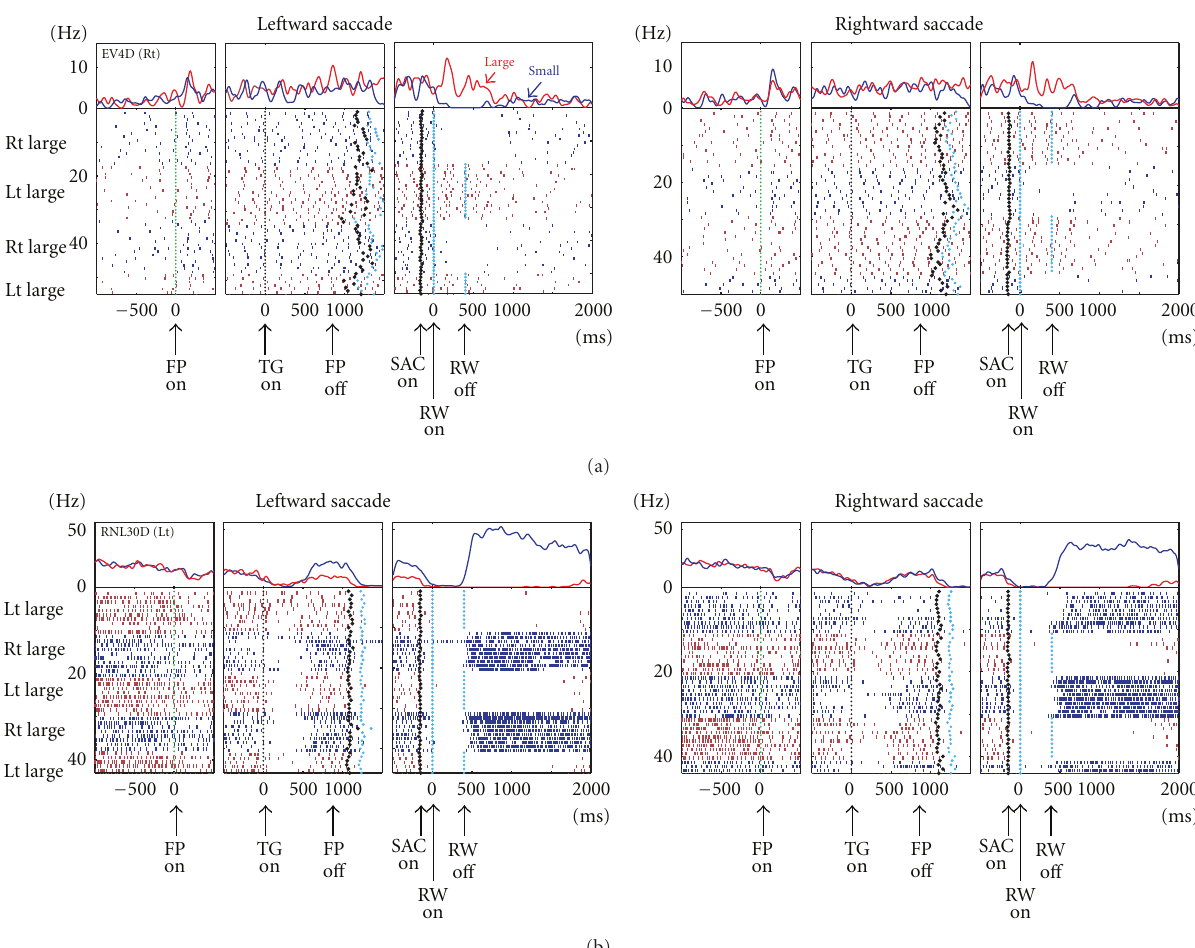
Figure 6: Activity of two example DRN neurons for the saccade task. For each neuron, (a) and (b), the rasters and histogramsfor the leftward and rightward saccades are shown separately. The changes in their firing rates are shown by the peritask event spike density function at the top. The activity in the large- and small-reward trials is shown in red and blue, respectively. The data are shown in 3 sections: the left section is aligned to the time of fixation point onset (FPon), the middle section is aligned to target onset (TGon) and fixation point o ff set (FPo ff ), and the right section is aligned to reward onset (RWon). Note that the reward o ff set (RWo ff ) applies only to the large-reward trials. The black dots indicate saccade onset (SACon), and the light blue dots indicate reward onset and o ff set. (Modified from